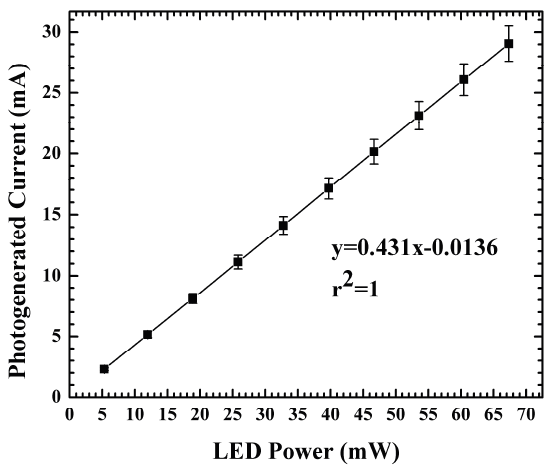
Figure 3. Photogenerated current from SBPSD as a function of incident LED power, showing the device responsivity in A/W as the slope of the